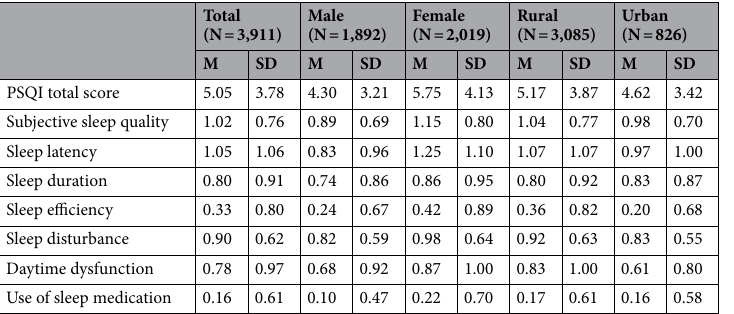
Table 2. PSQI total and component scores in all participants. M mean, PSQI Pittsburgh Sleep Quality Index, SD standard deviation.